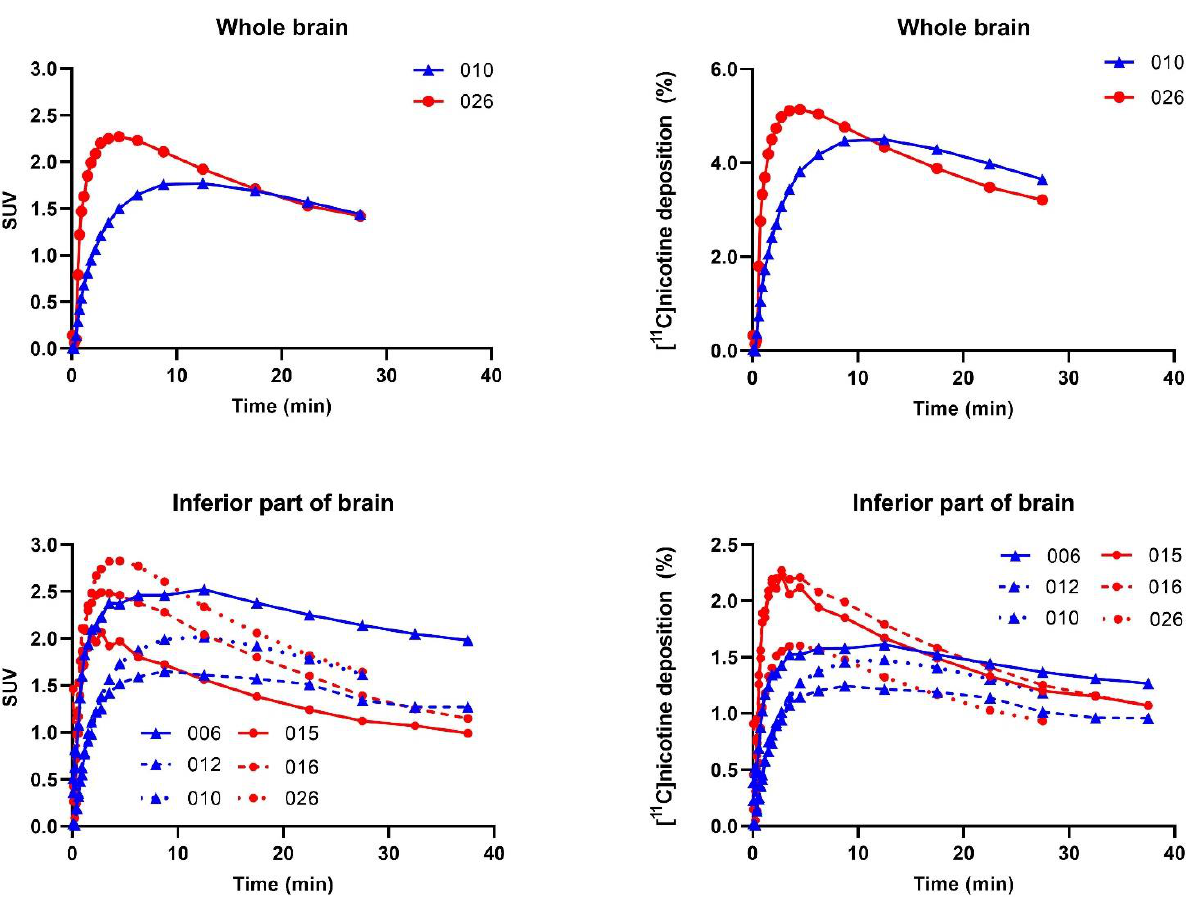
Figure 5. SUV versus time for all brain regions and subjects ([ 11 C]nicotine freebase blue plots (triangles) and [ 11 C]nicotine lactate red plots (circles). Subject numbers are given in each graph.